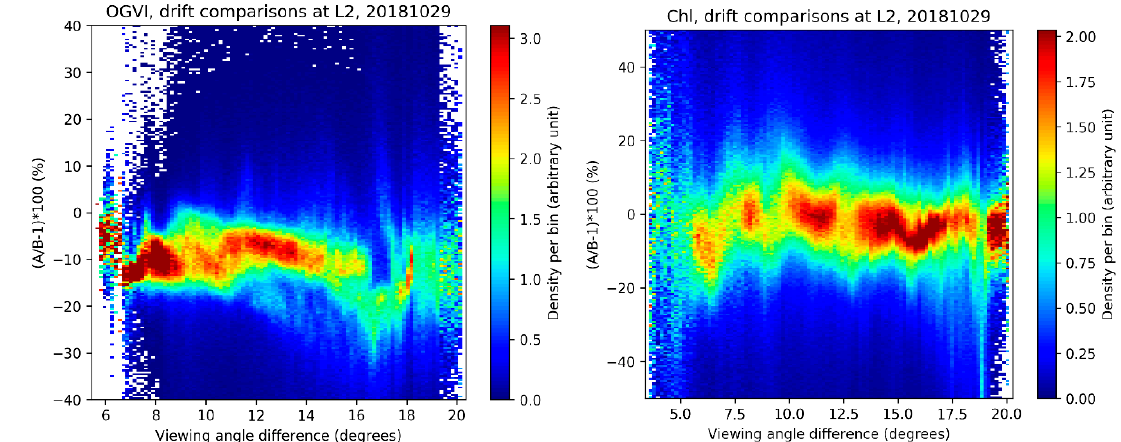
Figure 15. Inter-satellite comparisons of OLCI level 2 products OGVI ( left ) and chlorophyll concentration ( right ) during the drift phase: histograms of relative differences as a function of the differences in viewing angles. OGVI shows a relatively strong dependency on the viewing angle, while the chlorophyll retrieval algorithm seems to be immune to such geometric effects. Reprinted from [23].